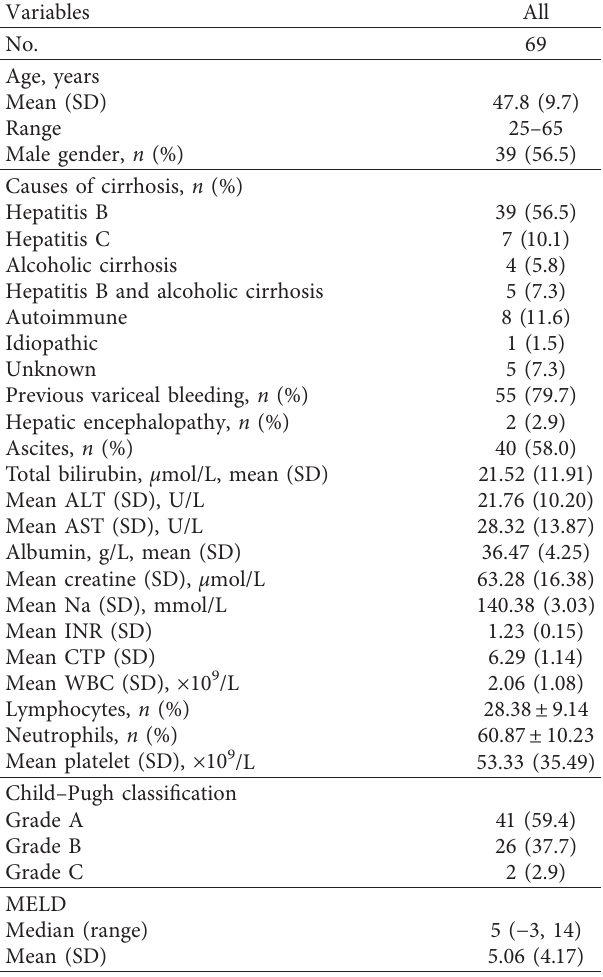
Table 1: Patient demographic and baseline characteristics. Variables